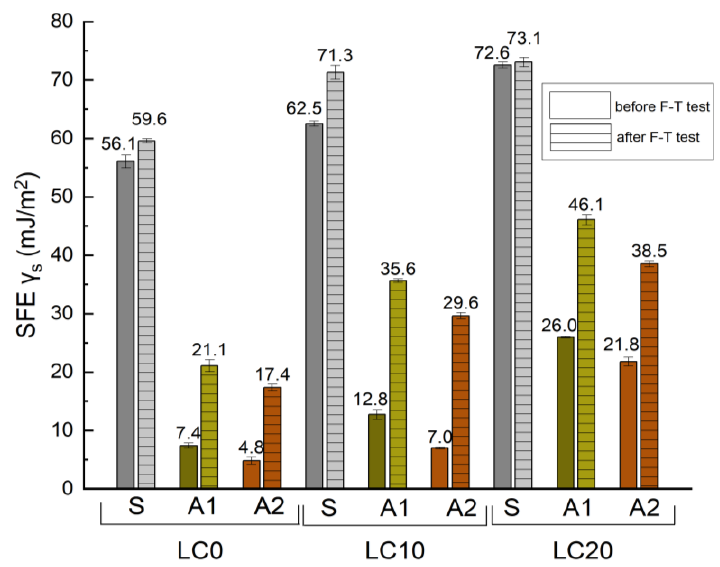
Figure 4. SFE values of LC before and after F–T cycles.